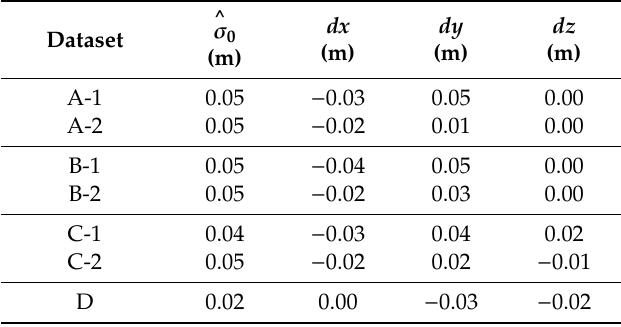
Table 6. Estimated X, Y, and Z discrepancies between the image-based dense point clouds generated using the refined IOPs and LiDAR point clouds for the seven